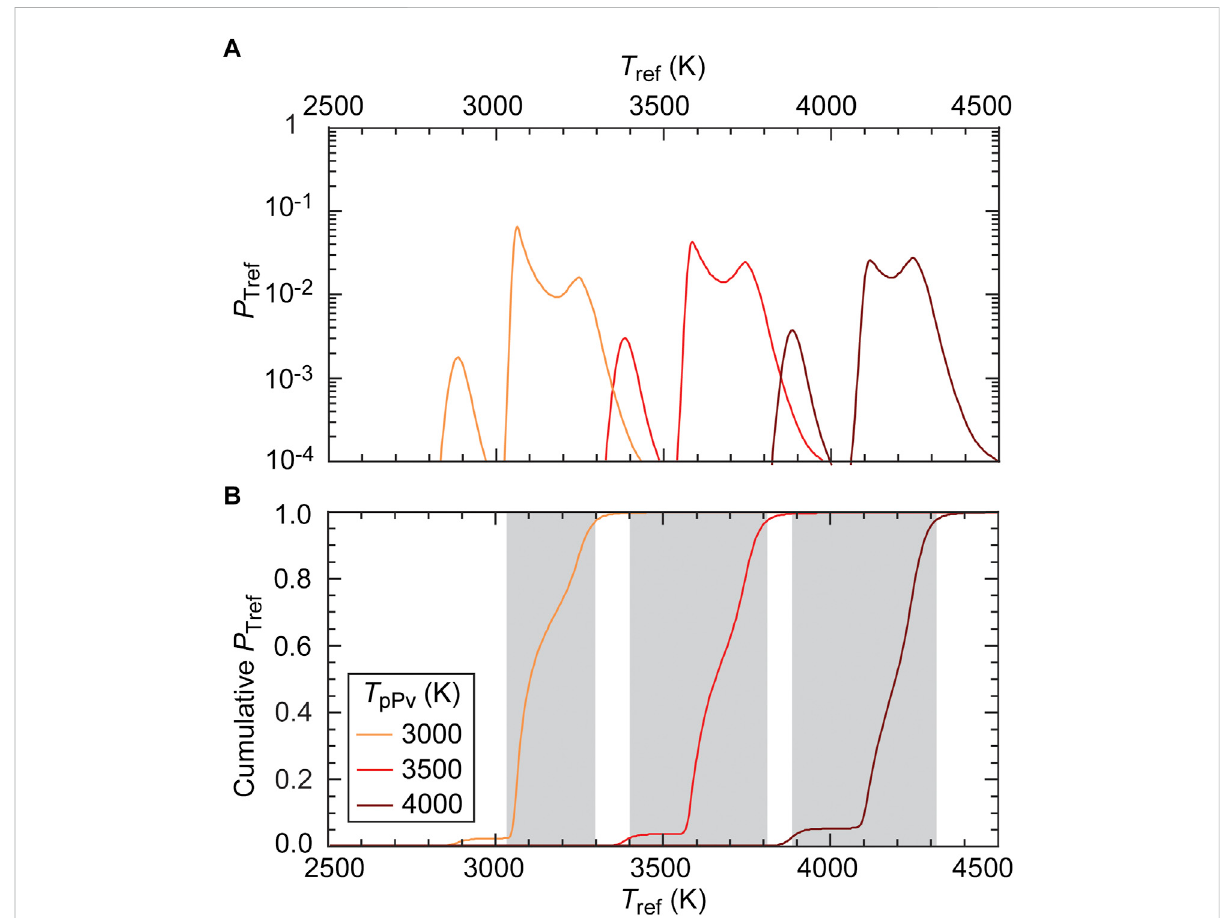
FIGURE 7 (A) Likelihoodsummed overtheexploredrange of α H as afunctionof T thethreecasesshowninplot (A) .Thegrayshadedbandscoverquartiles0.025to0.975,andthereforeindicatetherangeoftemperaturewithinwhich T ref has a 95% likelihood to